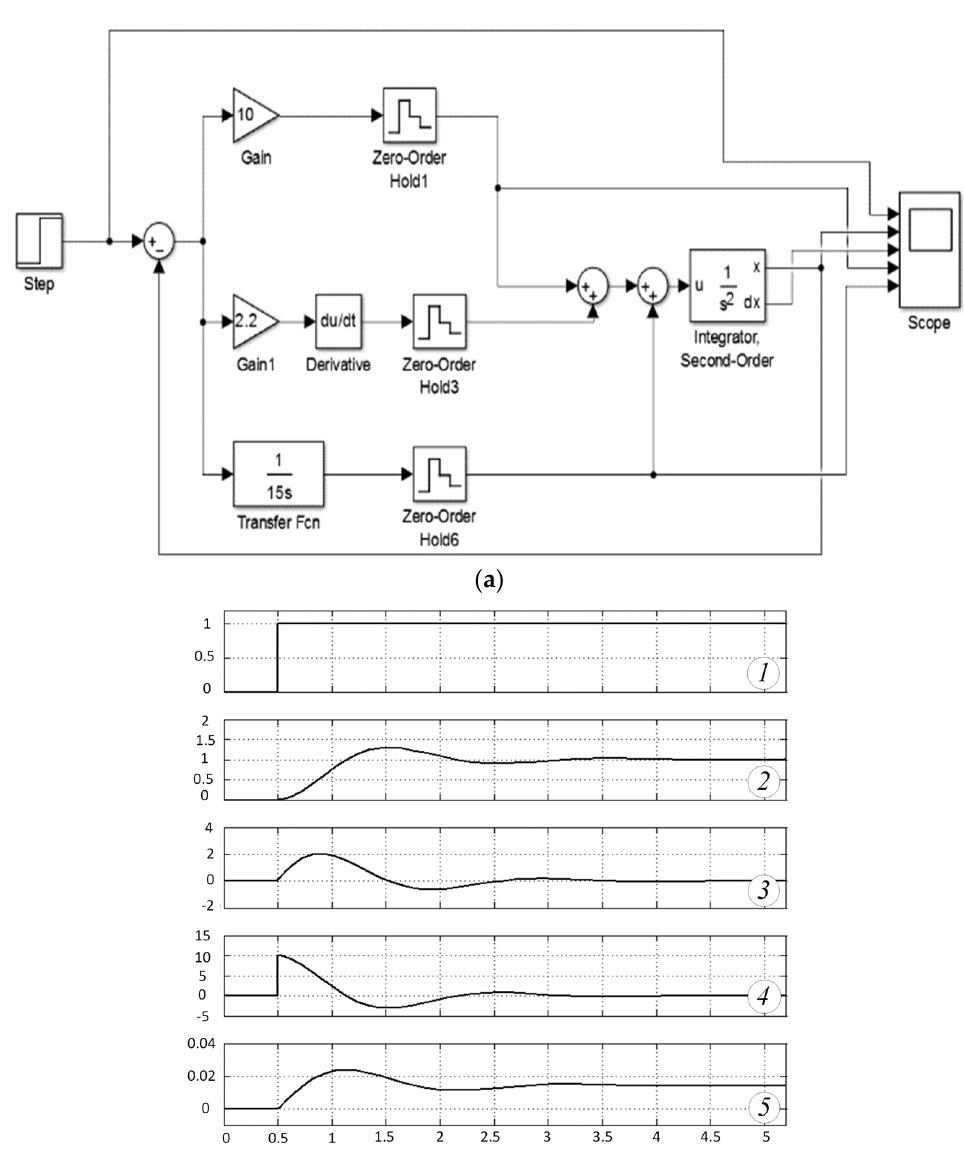
Figure 4. Diagram of the model with a PID controller ( a ) and diagrams of transient processes with zero delay times in the links “zero − order hold” ( b ). 1 Reference signal. 2 Controlled variable. 3 Derivative of the controlled variable. 4 Output signal of the differentiating channel of the controller after sampling. 5 Output signal of the integrator.